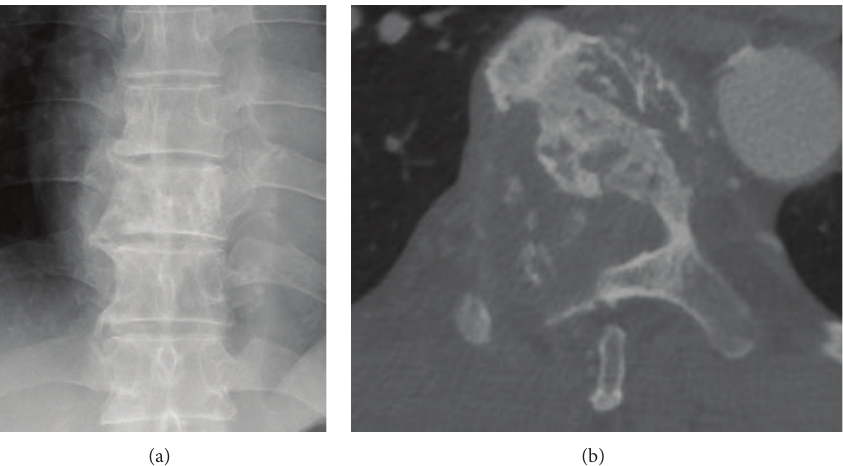
Figure 1: Preoperative images showing a vertebral tumor destroying the T9 vertebra and right pedicle. (a) Preoperative anteroposterior radiograph, (b) CT of the T9